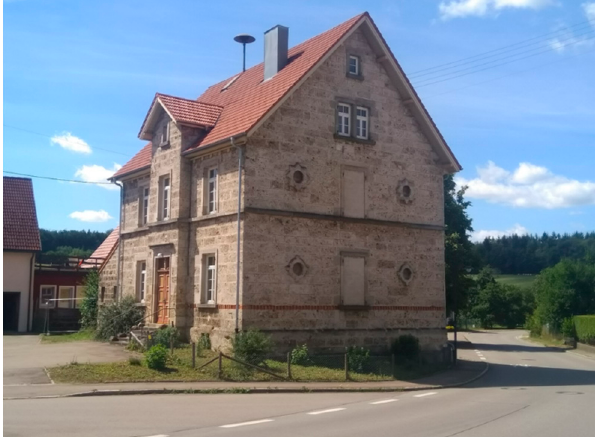
Figure 13. Possible volcano museum and visitor center in Böttingen (Author 2020).